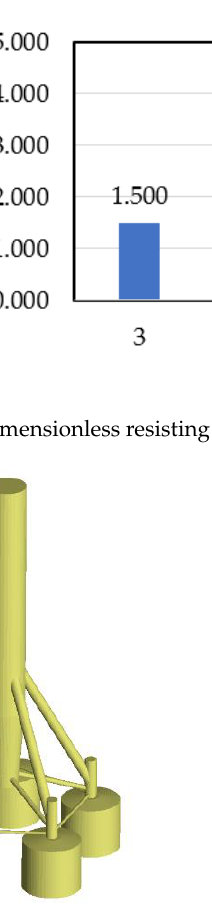
Figure 4. Pentapod support structure.